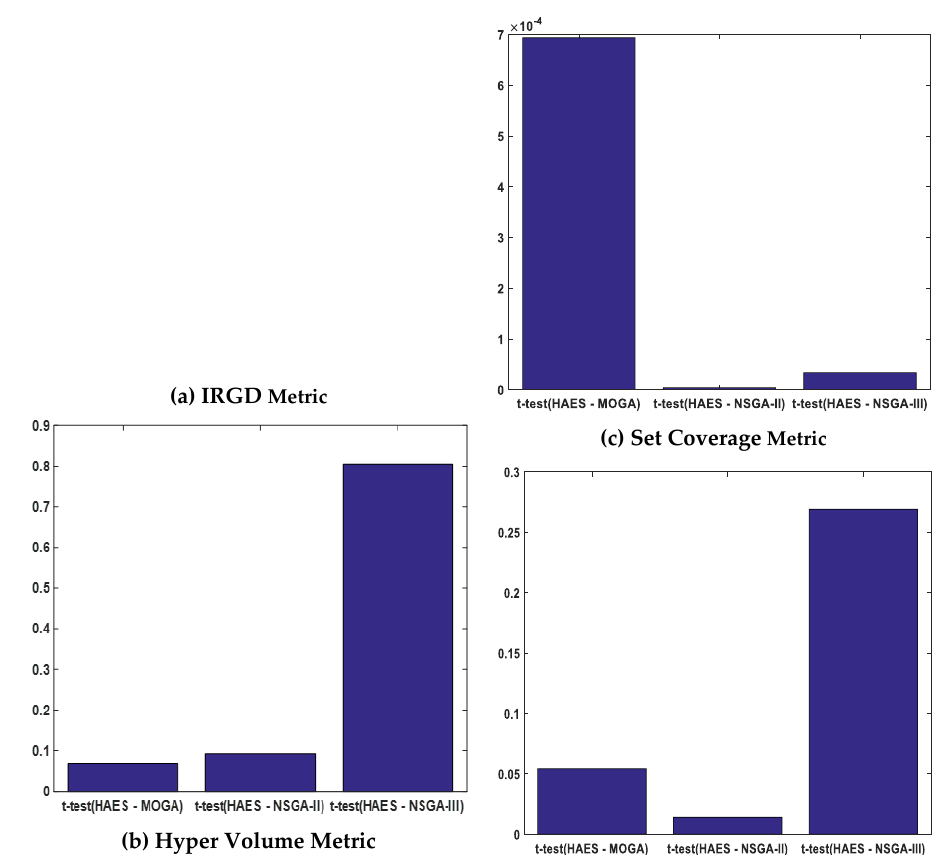
Figure 6. Comparison between HAES different configurations in terms of alpha and the other algorithms.